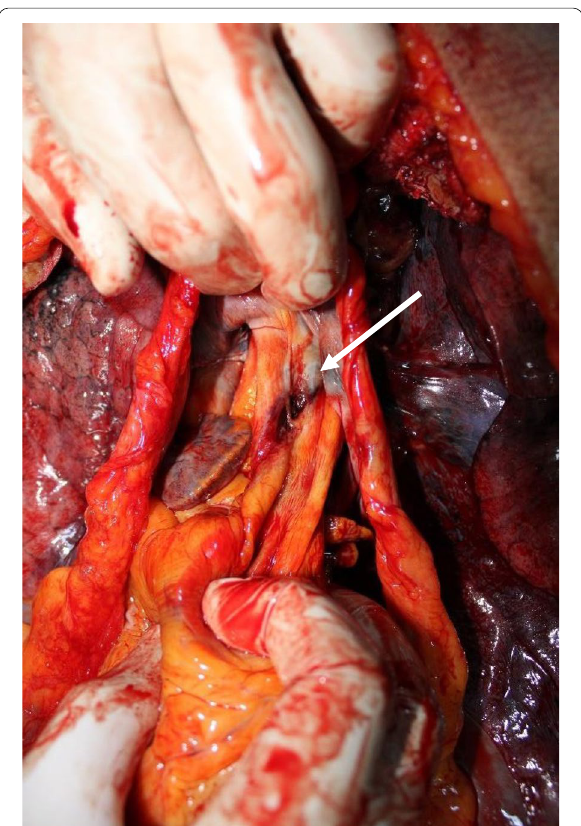
Fig. 4 Lacerations of the ascending aorta and the trunk of the pulmonary